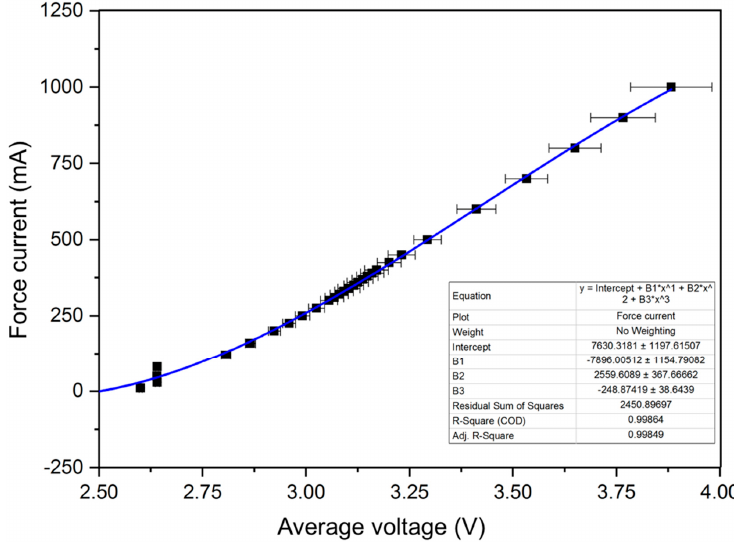
Figure 10. Measured forward bias current versus average forward bias voltage of seven custom GaN LED devices.